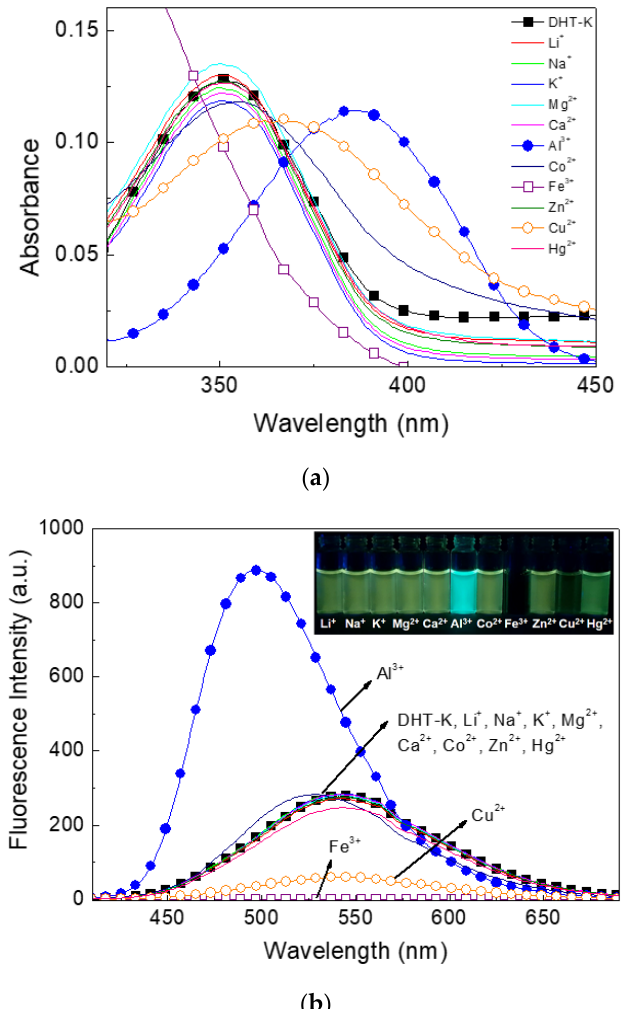
Figure 1. Changes in ( a ) UV–vis and ( b ) fluorescence spectra of DHT-K (19 µ M) in the presence of various metal ions (380 µ M) in aqueous solutions. Inset photograph: DHT-K with different metal ions under UV lamp (365 nm).